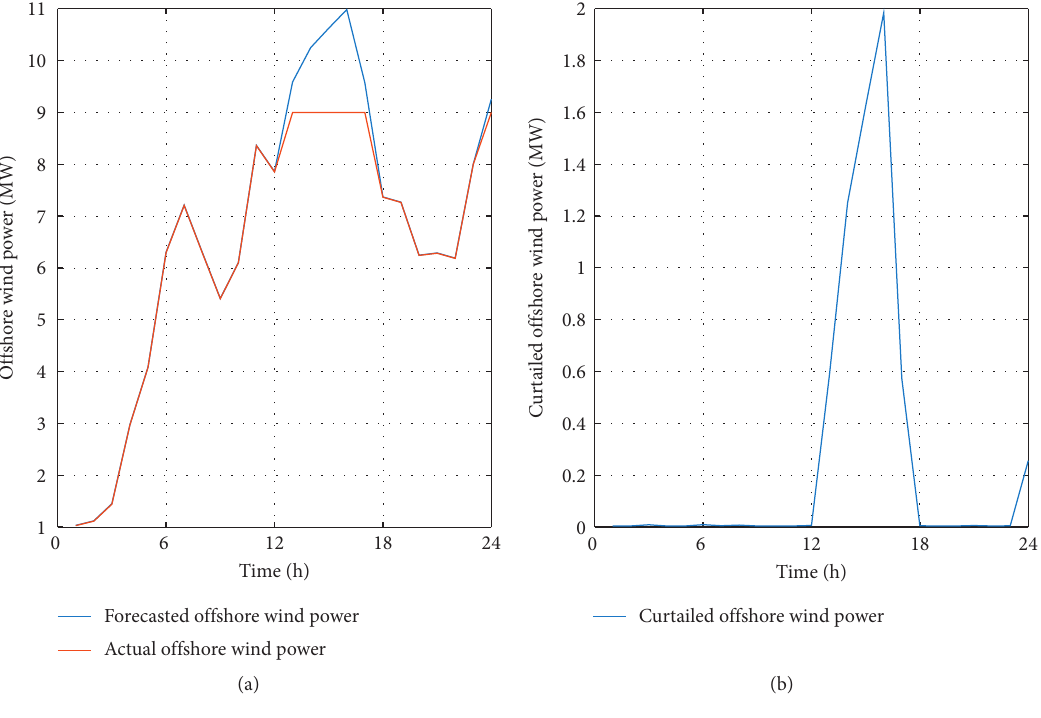
Figure 6: Forecasted and actual offshore wind power in scheme